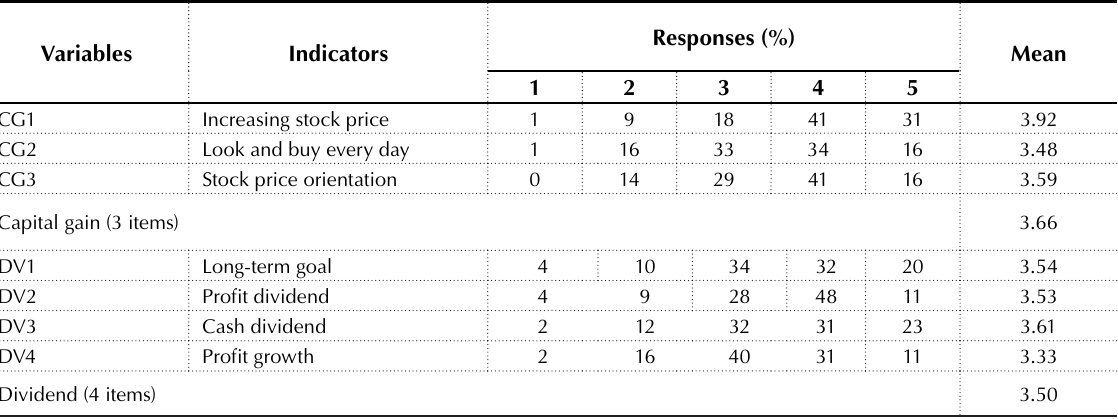
Table 6. Responses to stock market